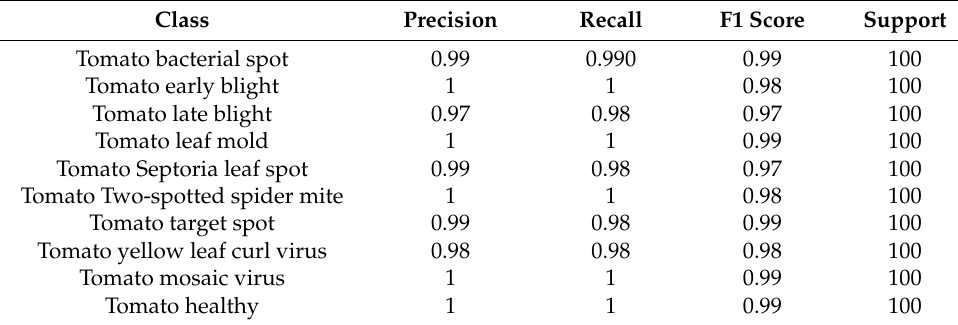
Table 3. Class-wise Performance of the Proposed Model.